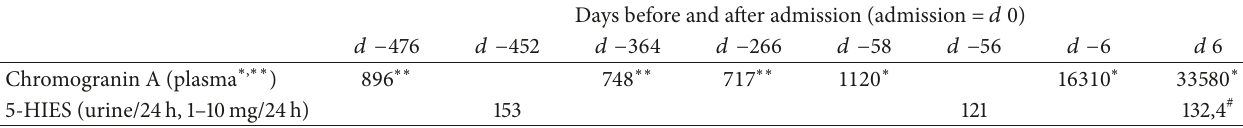
Table 3: Hormone levels in blood and urine.